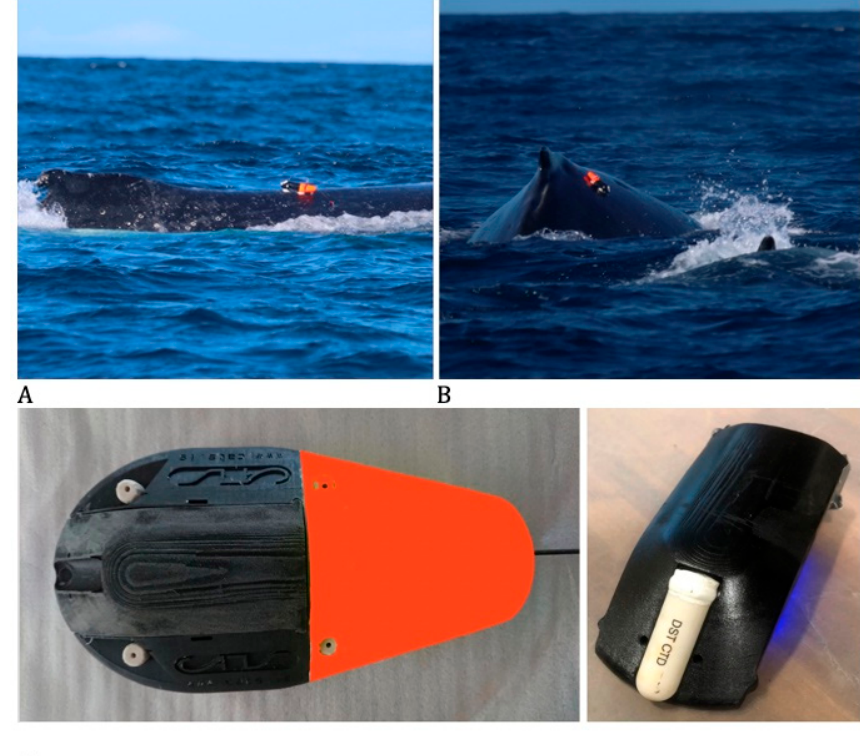
Figure 2. Suction cup tags deployment position. Near the top of the whale ( A , Tag 1) and slightly lower on the whale closer to the animal’s midline with the module facing more sideways ( B , Tag 2). Suction cup system with embedded GPS/GSM module and CTD unit ( C ).